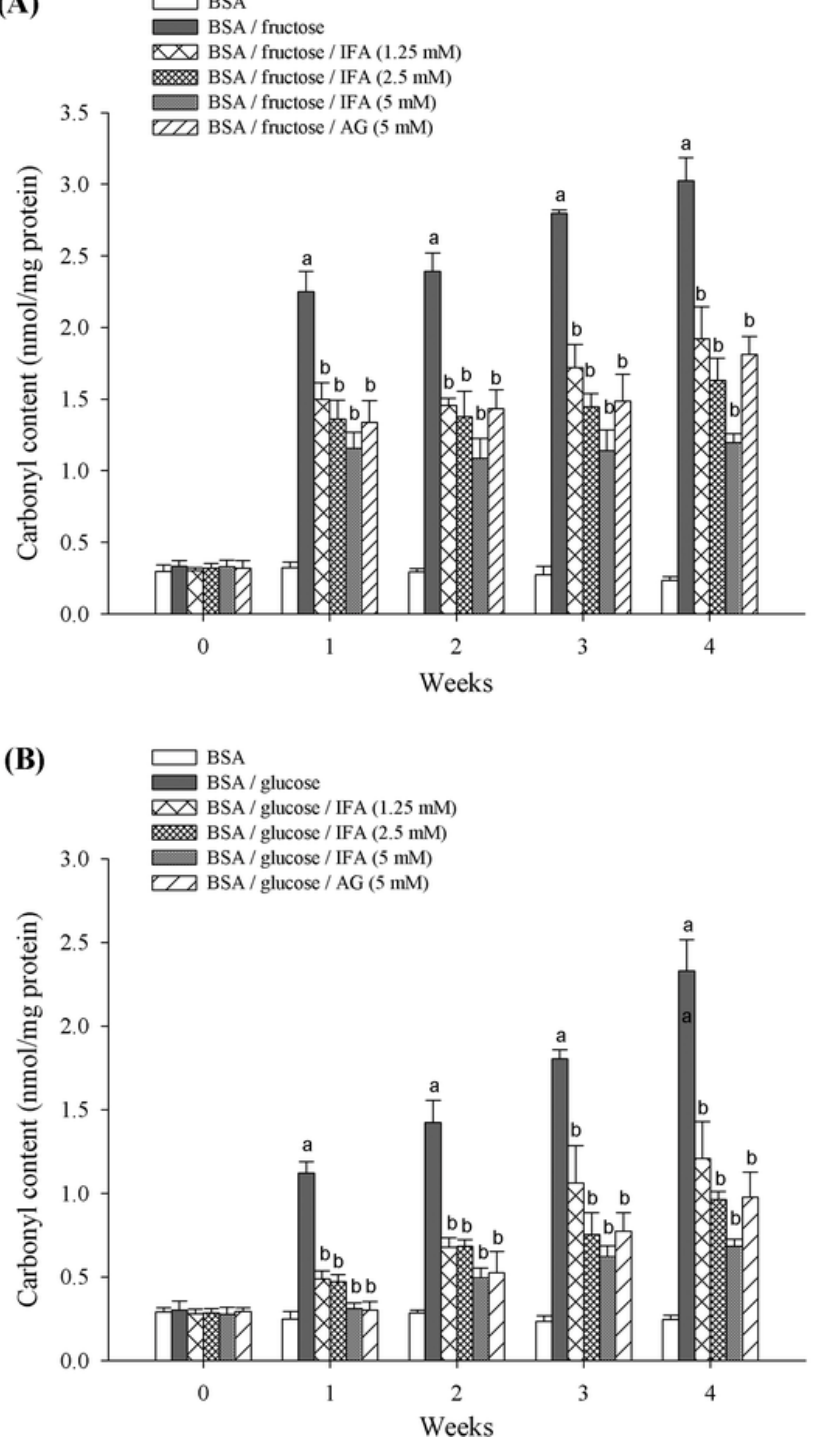
Figure 5. The effect of IFA on the protein carbonyl content in BSA/fructose and BSA/glucose systems. Results are expressed as mean ± SEM (n = 3). a p < 0.05 when compared to BSA, b p < 0.05 when compared to BSA/fructose or